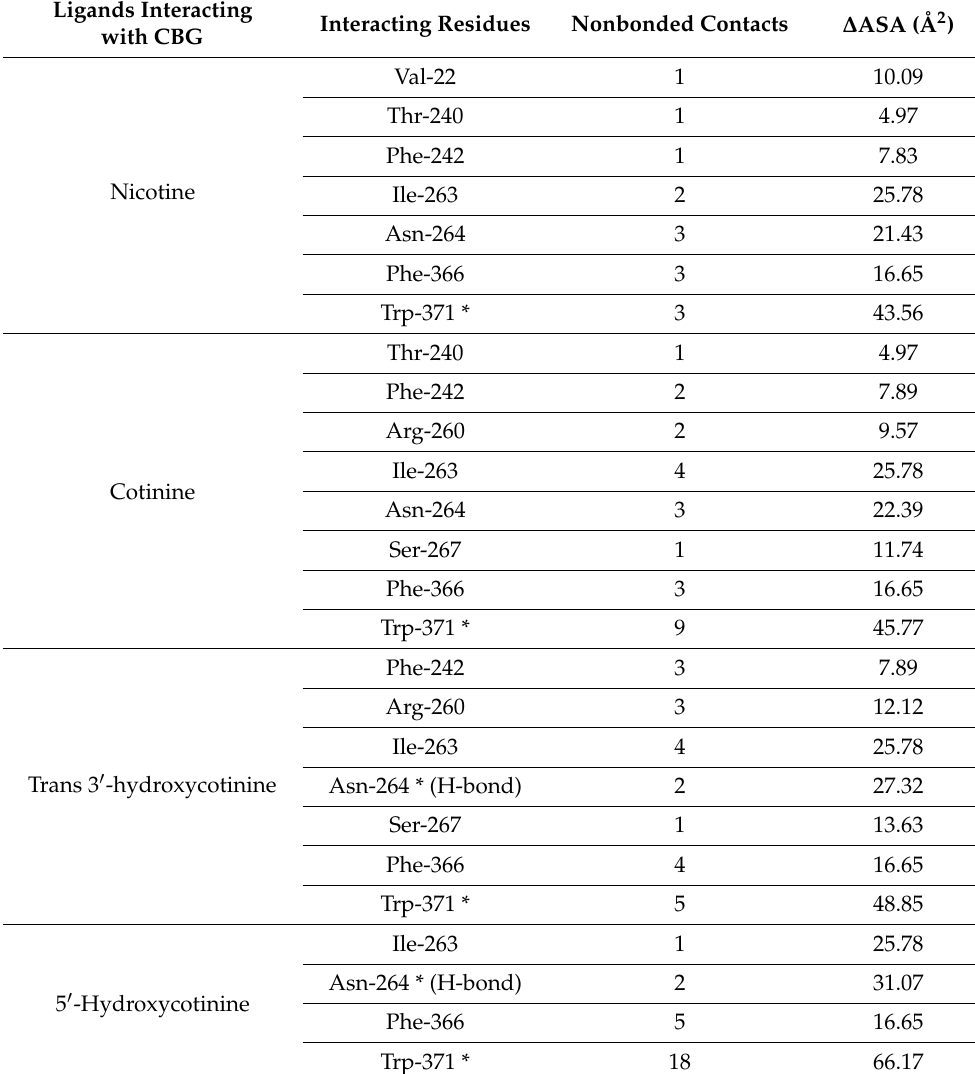
Table 5. The amino acid residues of corticosteroid-binding globulin (CBG) interacting with nicotine and its metabolites. Each residue is listed with the number of nonbonded contacts, loss in accessible surface area ( ∆ ASA) due to ligand binding, and hydrogen bonding (H-bond) interaction (when applicable). Amino acid residues with an asterisk are the most important residues showing the maximum number of nonbonded contacts and/or the maximum loss in ASA or